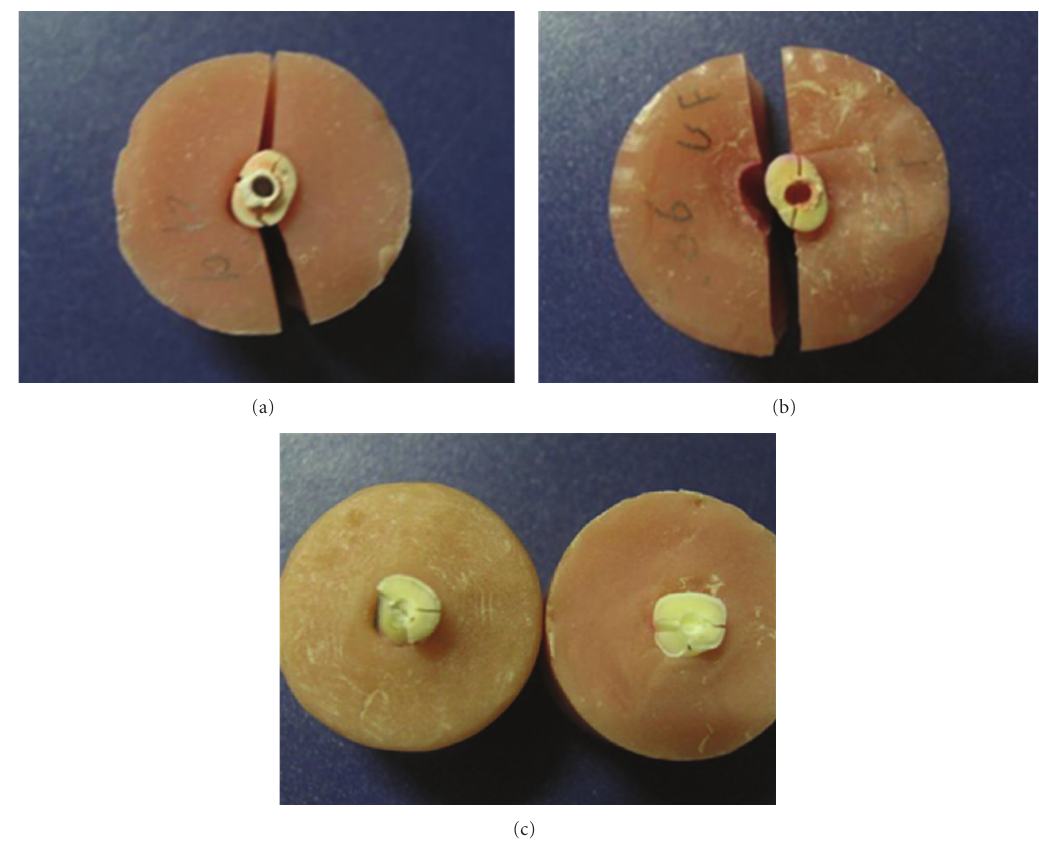
Figure 5: Patterns of root